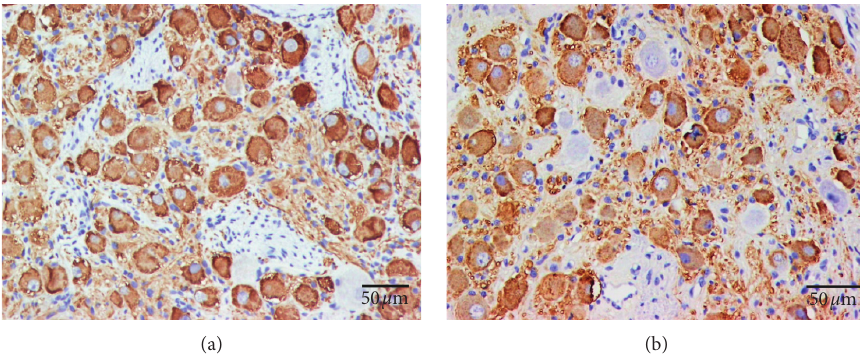
Figure 3: TH staining of RSG in both control group (a) and experimental group (b). (a) The RSG of the control group seen at high magnification. TH staining showed TH-negative ganglion cells (red arrows) and TH-positive ganglion cells (brown color) in RSG. (b) The RSG of the experimental group seen at high magnification. Compared with that of the control group, TH staining showed that the number of ganglionic cells was significantly decreased, but the quantity of TH-negative ganglion cells was significantly increased in the RSG of the experimental group.